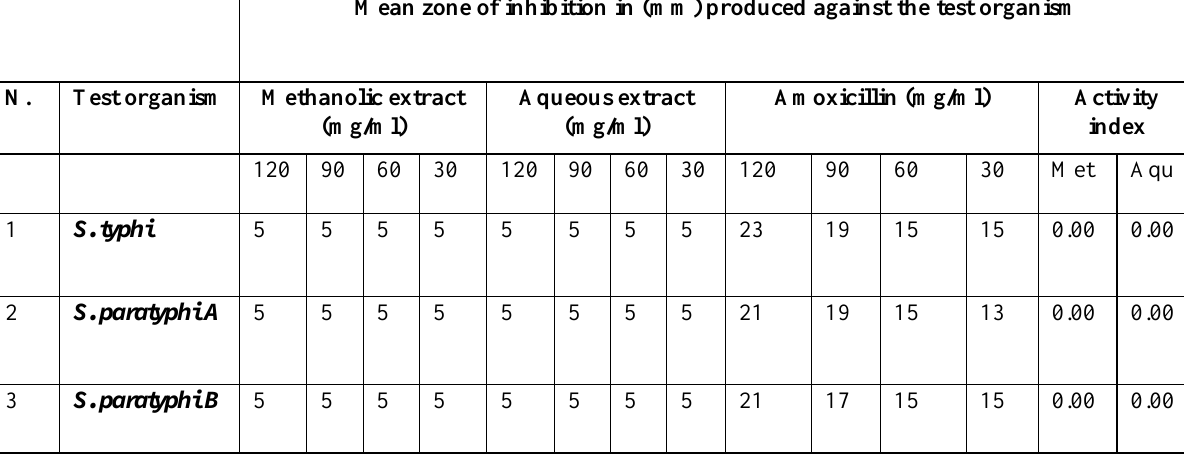
Table 4. Gas chromatography mass spectrometry analysis on C. sinensis water extract . Nineteen (19) compounds were identified in the preliminary GC-MS of this extract and the major compounds include.